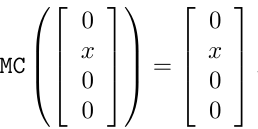
Algorithm 4.1 and 4.2 show pseudo-code for the encryption and decryption functions respectively. Lemma 1 shows that the two algorithms can be efficiently merged. We further